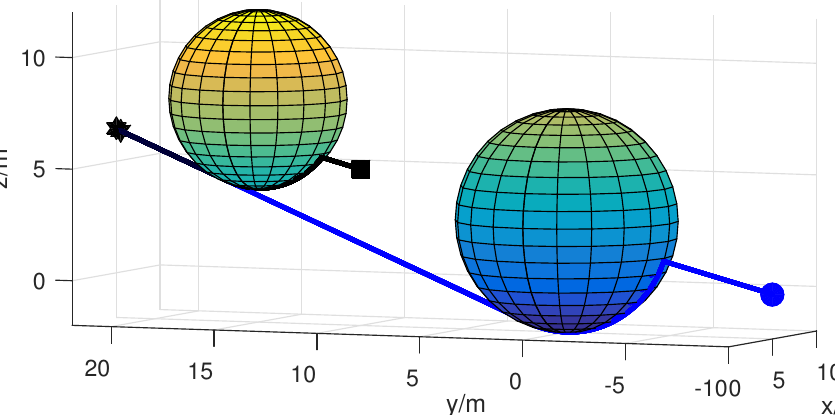
Figure 5. Comparison results of space trajectories. The blue line is pursuit trajectory, while the circle is the start point of pursuer. The black line are evasion trajectory, while the square is the start point of